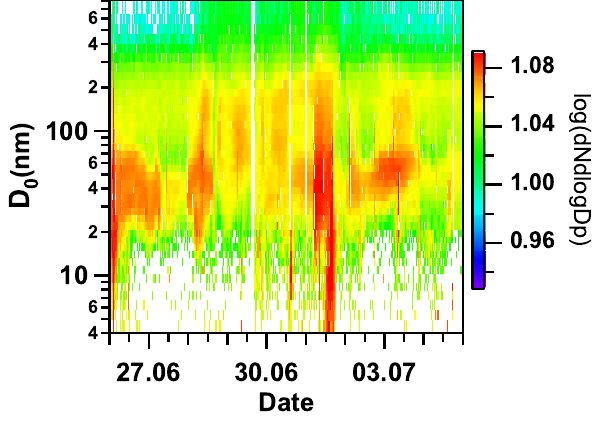
Fig. 11. The aerosol particle number size distribution measured during the MAP Celtic explorer